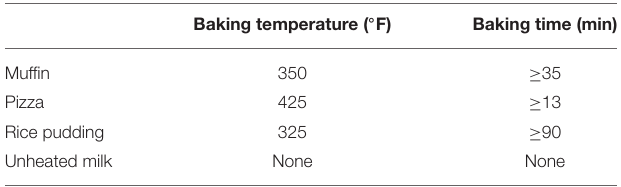
TABLE 3 | Baking temperature and time of milk products used in the “milk ladder”